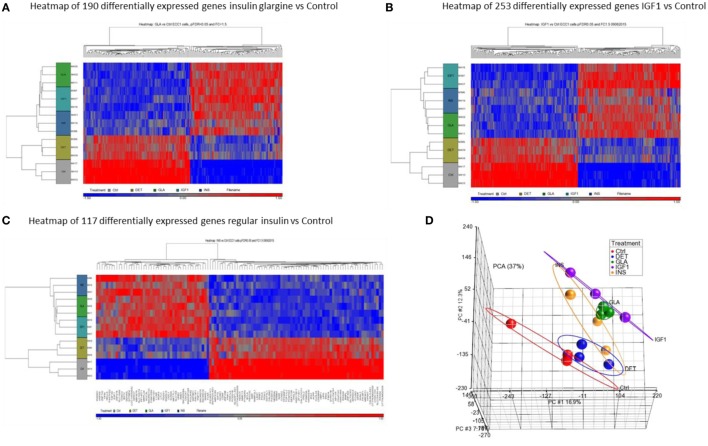
Hierarchical clustering map of differential gene expression in ECC-1 cells. Heatmaps of microarray results in the ECC-1 cell line after treatment with insulin glargine (A), IGF1 (B), and regular insulin (C). The figures depict heatmaps of differentially expressed genes [FC > 1.5 or <−1.5 and p-value (FDR) < 0.05]. The scale below indicates the relative changes in gene expression represented by red (upregulated genes) and blue (downregulated genes) colors. (D) Principal component analysis (PCA) of all 15 arrays of ECC-1 cells (three biological replicates were performed for each treatment). Each data point represents RNA sample applied to microarray: red (untreated cells—Control, Ctrl), blue (Detemir, DET), green (Glargine, GLA), violet (IGF1), and orange (regular insulin, INS).